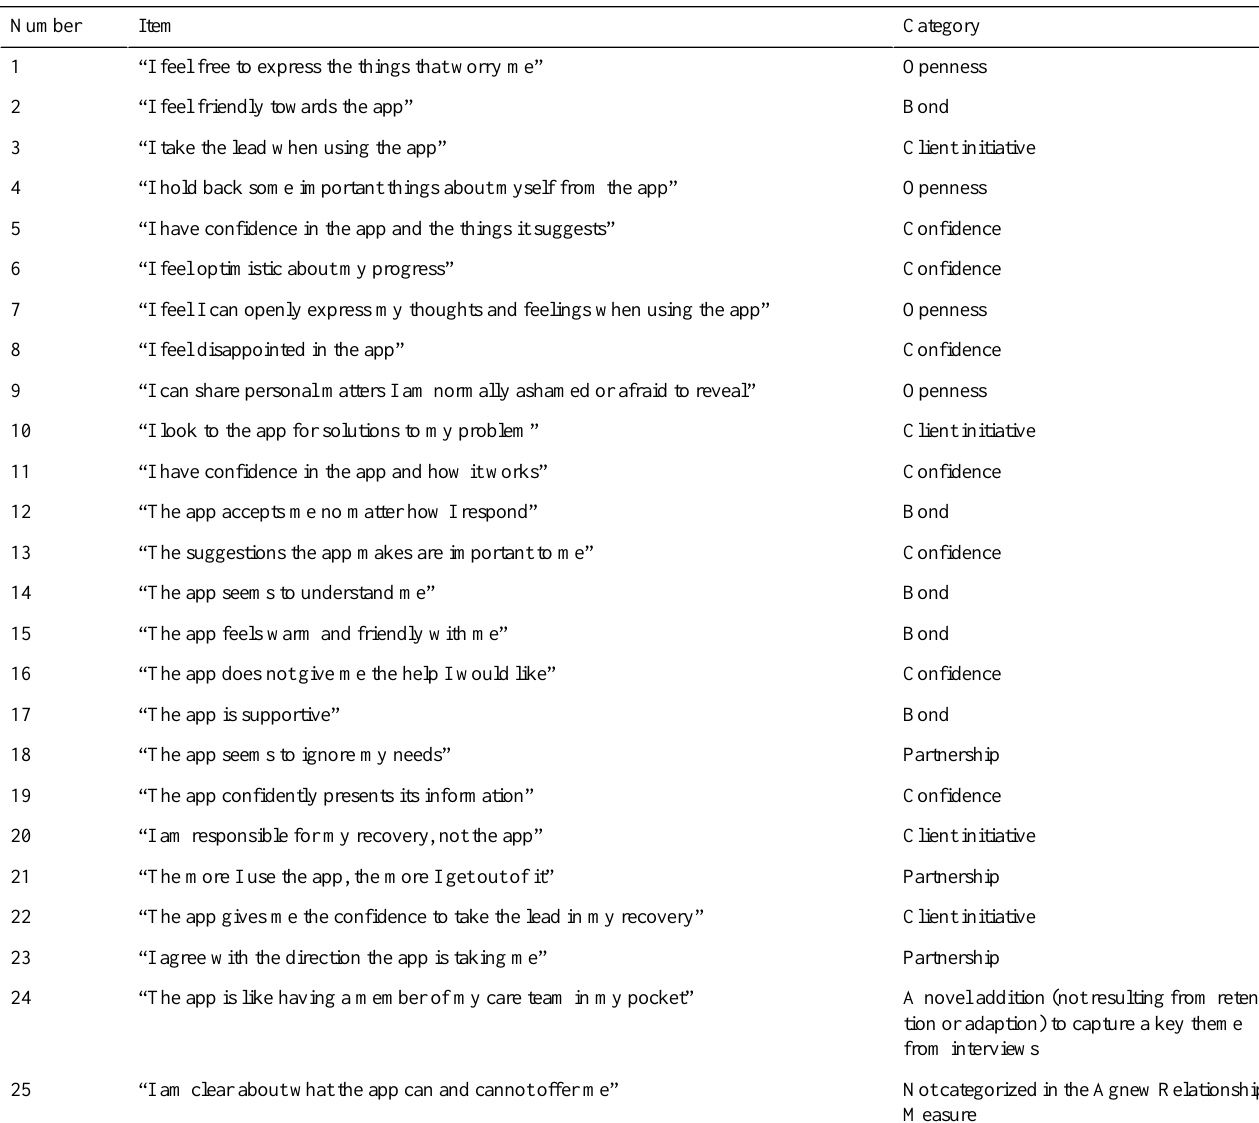
Table 2. Items of the Mobile Agnew Relationship